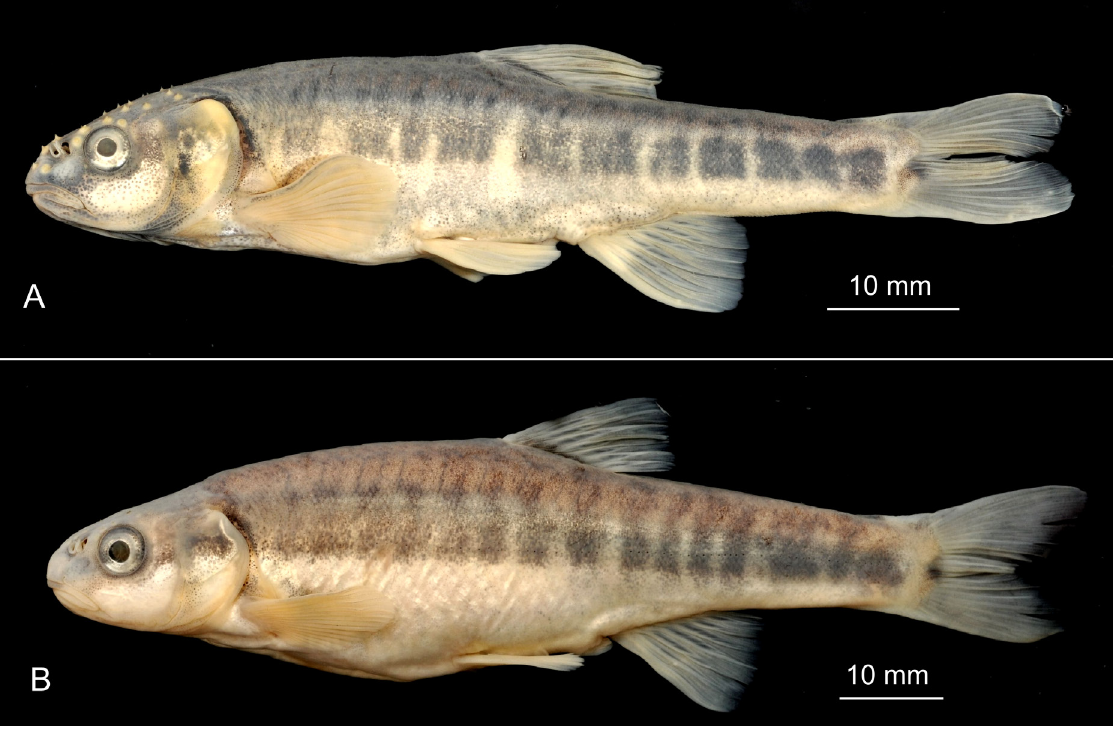
Fig. 5. A . Neotype of Phoxinus chrysoprasius (Pallas, 1814), ♂ (ZFMK 93640-59). B . ♀ (ZFMK 93640- 59), 87.2 mm SL, same locality and date as